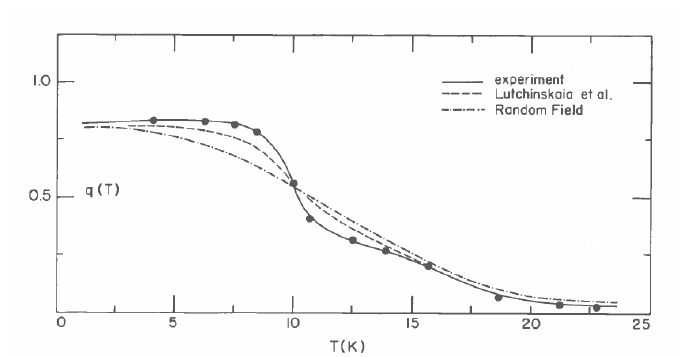
Figure 10. Temperature dependence of the quadrupolar glass order parameter q EA ( T ) . Reproduced with permission from [41]. Copyright Taylor & Francis,